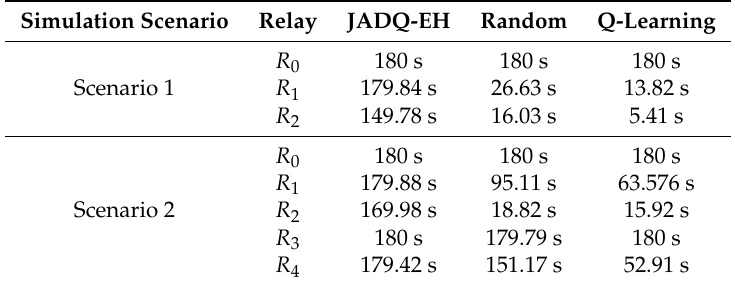
Table 10. The J ave of relay nodes comparison under different scenarios.